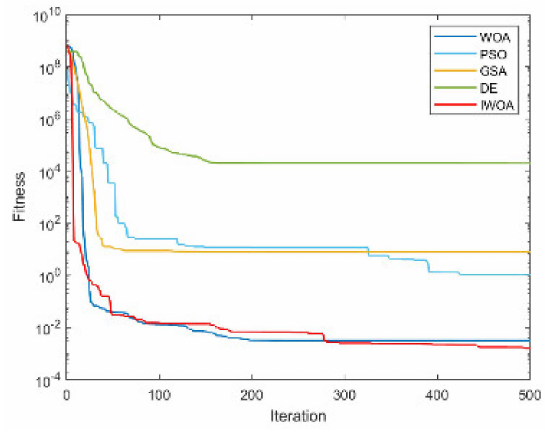
Figure A8. The convergence curve for solving